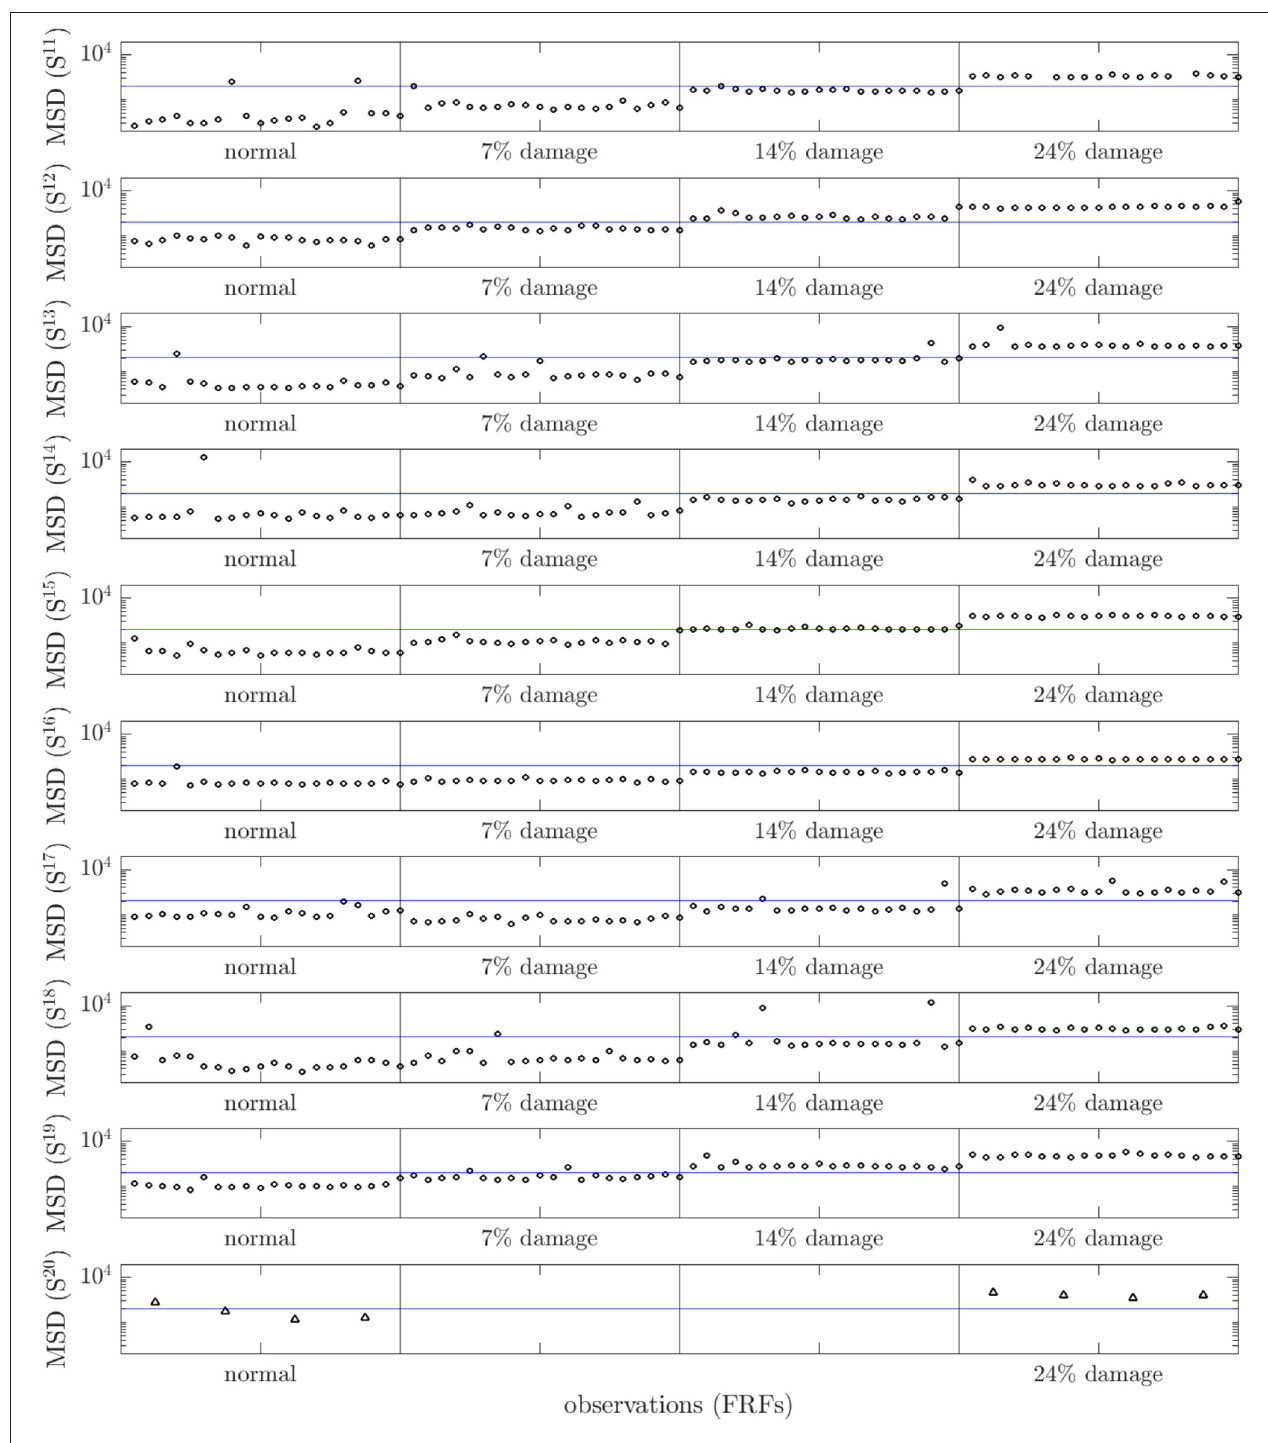
FIGURE 5 | MSD novelty index for the test-data FRFs, comparing members 11–20. These members did not contribute training data to learn the form. The dot markers are used for simulated members 11–19, while triangle markers are used for the test-rig, member 20.